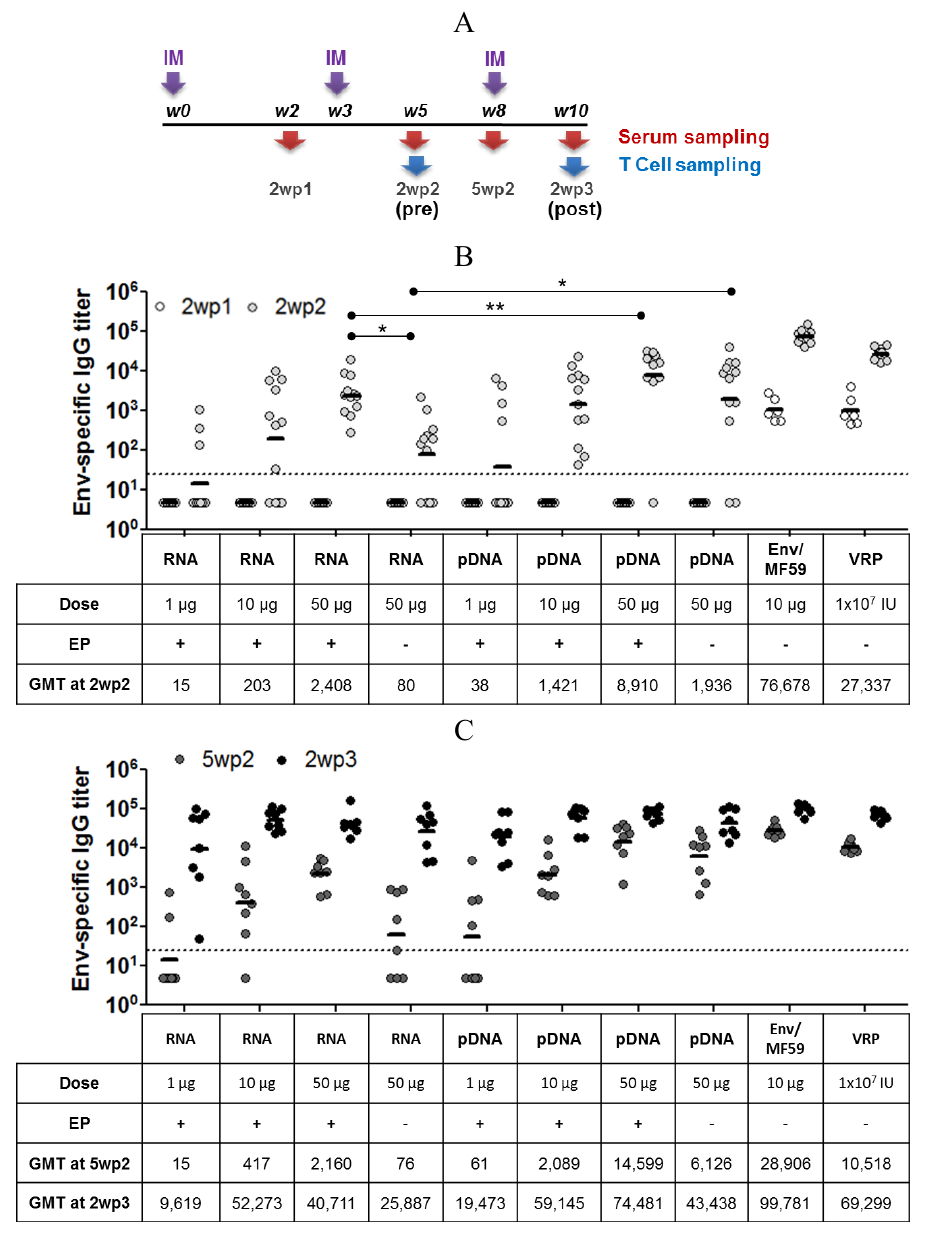
Figure 3. Study timeline for assessment of self-amplifying mRNA vector in an HIV immunogenicity model. ( A ) Female Balb/C mice received 2 treatments of RNA or pDNA vectors with or without EP (RNA or pDNA, 1, 10 and 50 µg), MF59-adjuvanted gp140.SF162 HIV envelope protein (Env/MF59, 10 µg) or viral replicon particles (VRP, 1 × 10 7 IU) expressing the HIV Env-protein at weeks 0 and 3. All groups then received a single injection of 10 µg Env/MF59 at week 8. Serum and mucosal samples, and spleens for T-cell quantitation were collected on week 2 (2wp1), 5 (2wp2, pre-protein boost) 8 (5wp2) and 10 (2wp3, post-protein boost). Env-specific total IgG titer for all groups at 2wp1 and 2wp2 ( B ) and 5wp2 and 3wp2 ( C ) is plotted as log of mean titer, and the horizontal bar represents geometric mean titer (GMT). Titers < 25 (dotted line) were assigned a value of 5 for calculation of GMT. n = 6 at 2wp1, n = 12 at 2wp2, and n = 8 at 5wp2 and 2wp3. * denotes statistical significance with p < 0.05; ** denotes statistical significance with p <